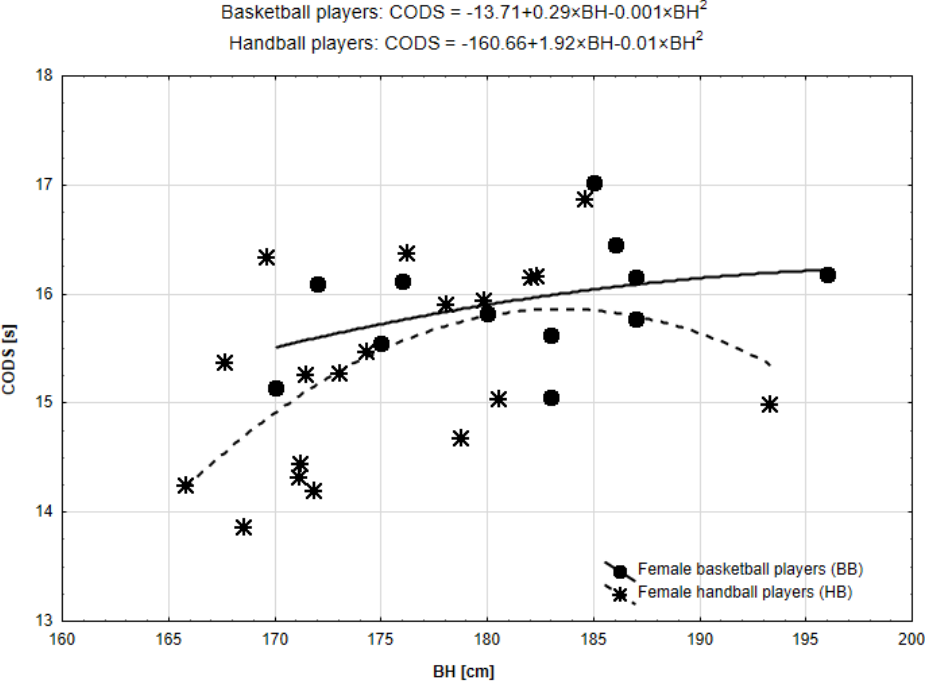
Figure 2. Functional forms of the relationships between body height (BH) and change of direction speed (CODS) in BB and HB.